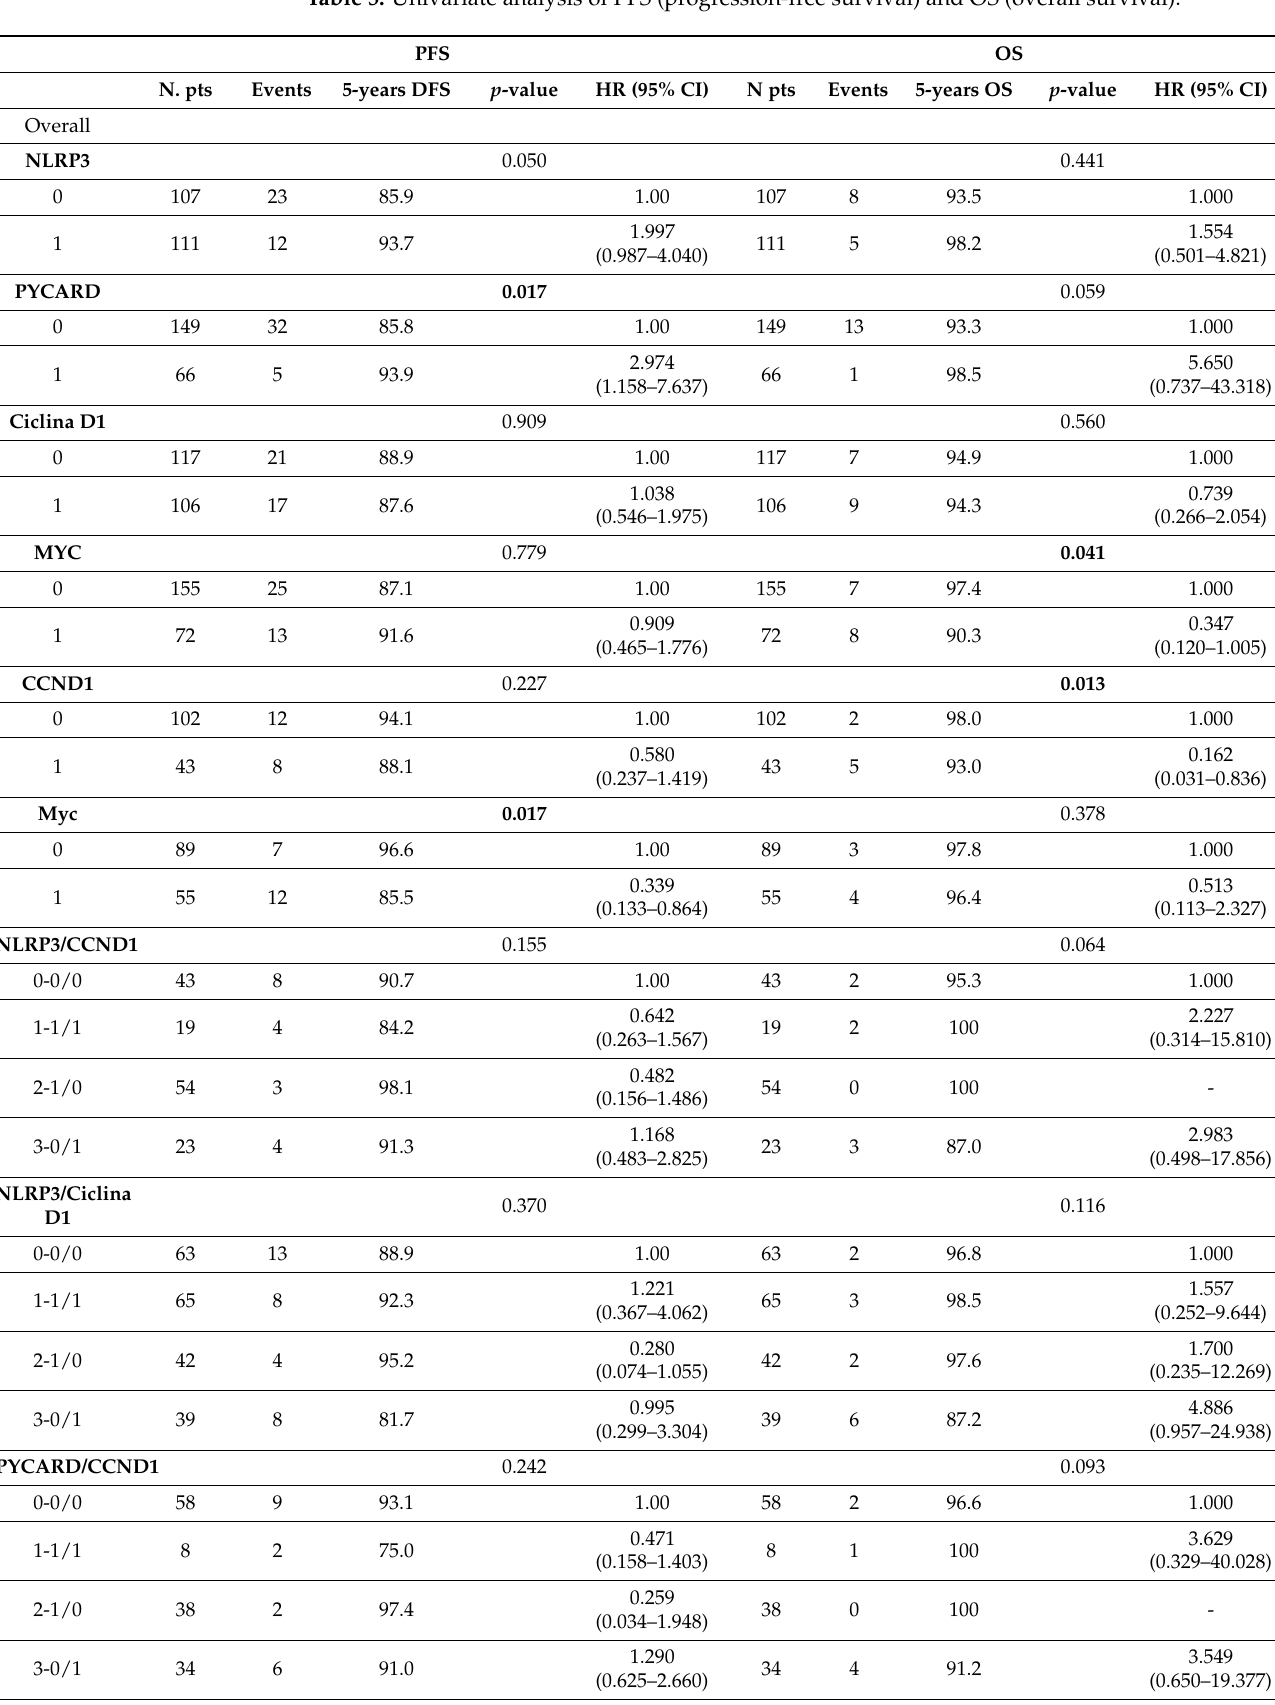
Table 5. Univariate analysis of PFS (progression-free survival) and OS (overall